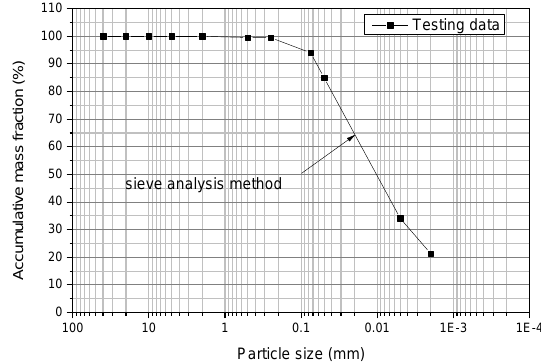
Figure 1. Particle size distribution obtained by the sieve analysis method.